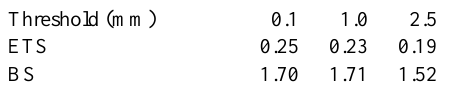
Table 1. Values obtained for the ETS and BS of accumulated rain- fall modelling in periods of six hours, for different thresholds.